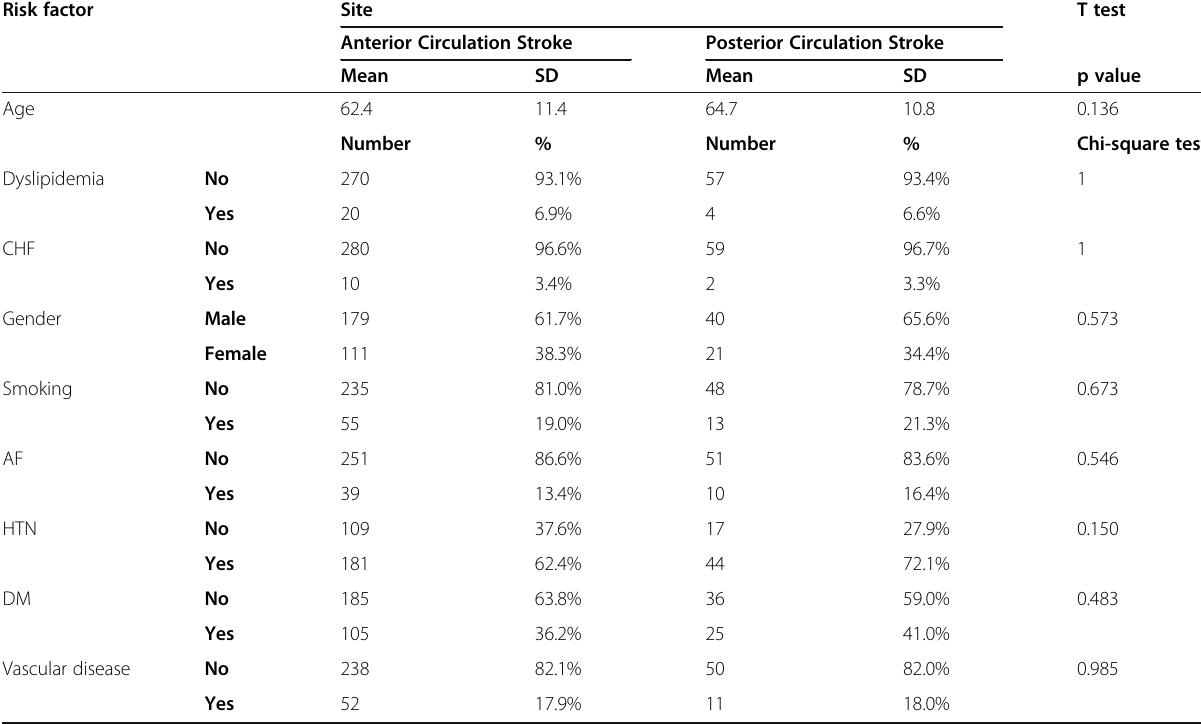
Table 1 Comparison of the distribution of risk factors among the two study groups and assessment of its significance